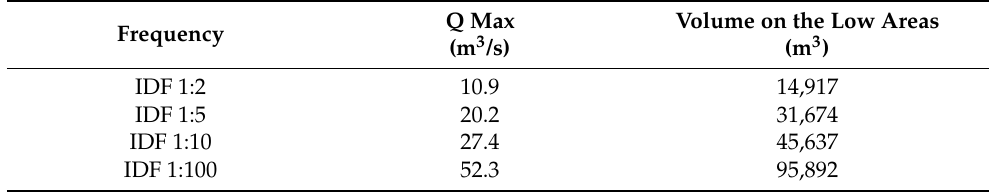
Table 2. Characteristics of the Design Flood Hydrograph in BH_3, Hypothesis 2.